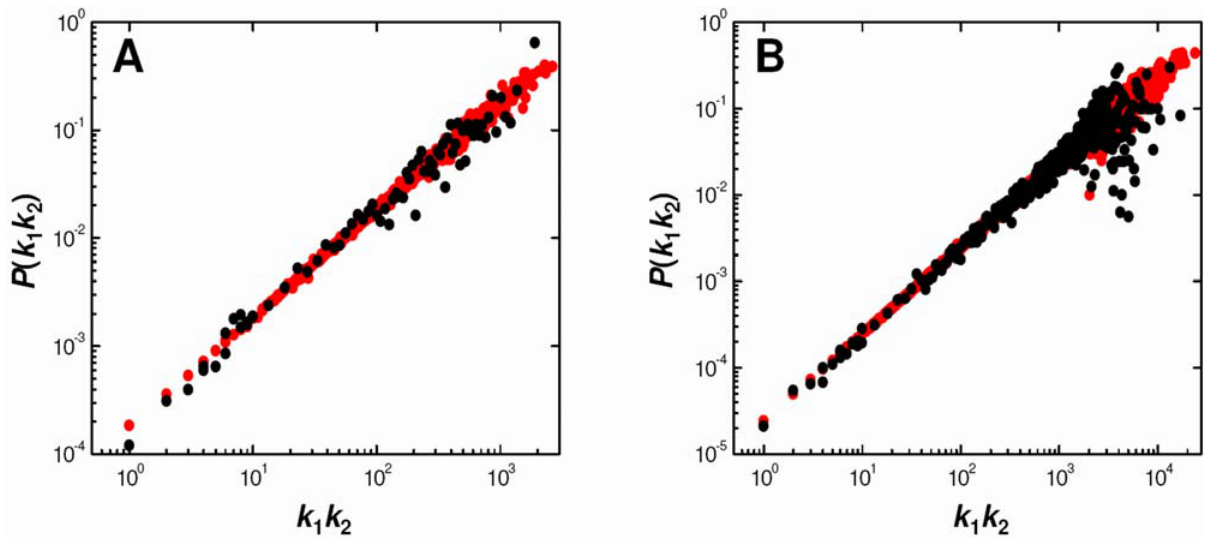
Figure 2. Degree-Weighted Connectivity in Two PPI Networks and Their DCDW Equivalents. (A) Plasmodium falciparum and (B) Drosophila melanogaster . Points in black correspond to the PPI networks and points in red correspond to their DCDW equivalents. For the PPI networks, probabilities of interaction P ( k 1 , k 2 ) were ordered by k 1 k 2 , and values for k 1 k 2 . 10 were averaged in groups of 10. For the DCDW networks, probabilities of interaction were averaged over 100 realizations and all values are shown.